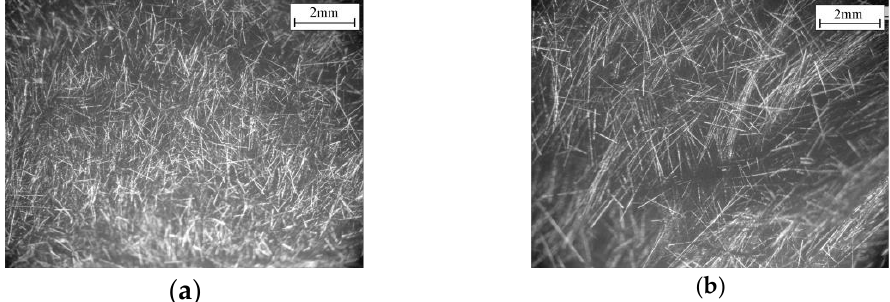
Figure 3. The optical images of NWCT made of chopped carbon fibers ( a ) short carbon fibers (SCFs), ( b ) long carbon fibers (LCFs).